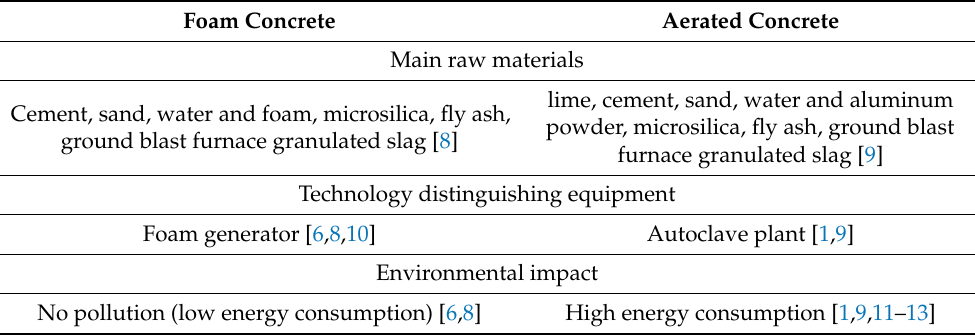
Table 1. Comparison of foam concrete and aerated concrete.